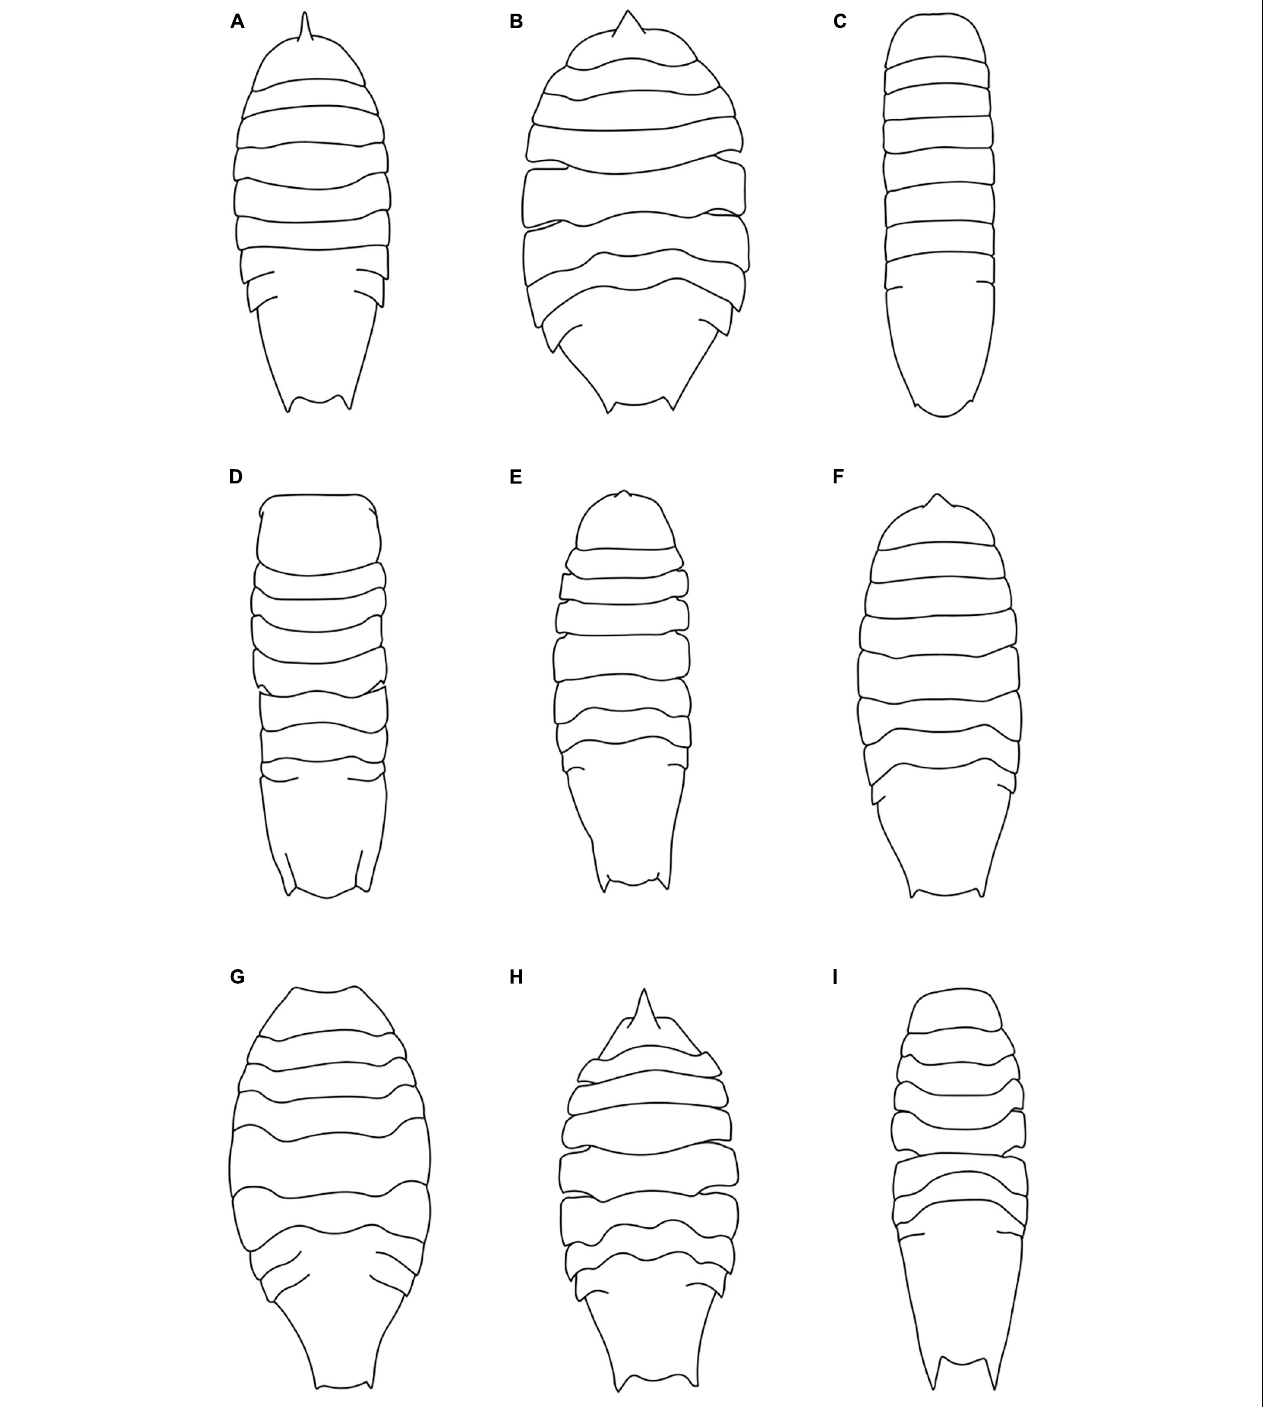
FIGURE 5 | Habitus drawings of Haploniscus aduncus (A) H. ampliatus (B) H. angustus (C) H. astraphes (D) H. bicuspis (E) H. borealis (F) H. foresti (G) H. hamatus (H) H. spinifer (I) (Modified after Brökeland and Wägele, 2004; Brökeland and Svavarsson, 2017).